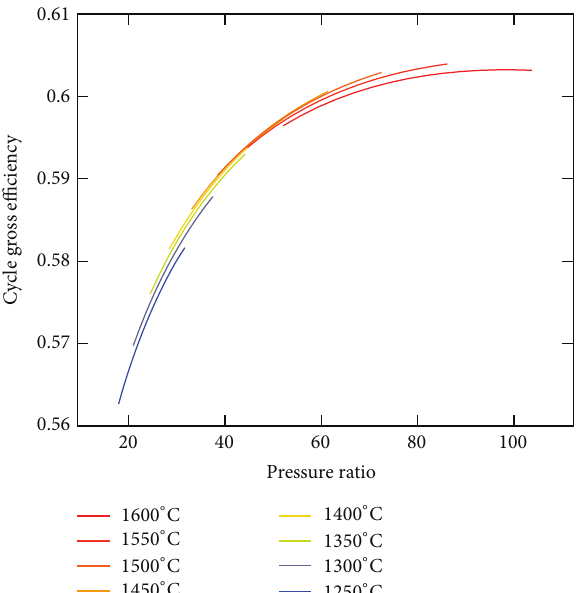
Figure 6: Gross efficiency as function of pressure ratio and turbine entry temperature for the SCOC-CC.